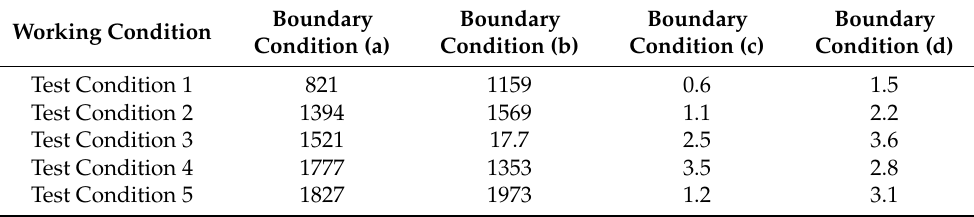
Figure 2. Bimodal temperature field model in the computational domain at z = 1.5 m: ( a ) a = 1200, b = 1200, c = 1.0, d = 3.0; ( b ) a = 1700, b = 900, c = 2.0, d = 3.0. Table 1. Boundary conditions of test dataset.